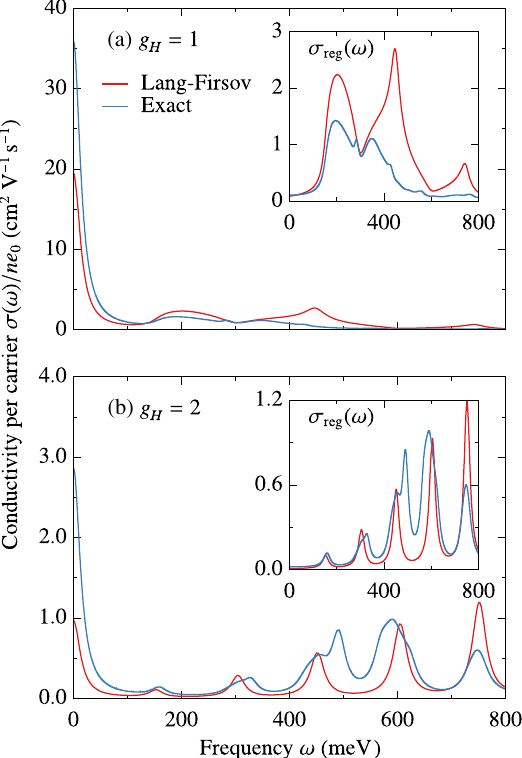
FIG. 7. The per-particle optical conductivity σ ð ω Þ =ne 0 of the Holstein model at zero temperature obtained by numerically exact EDVHS and approximate Lang-Firsov treatment. Insets show the non-Drude regular conductivity σ D δ ð ω Þ . Parameters are the same as in Fig. 5 except the broad- ening is η ¼ 15 meV. Note that the vertical scales of (a) and (b) differ by a factor of